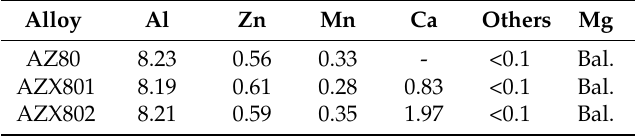
Table 1. Chemical compositions of the alloys